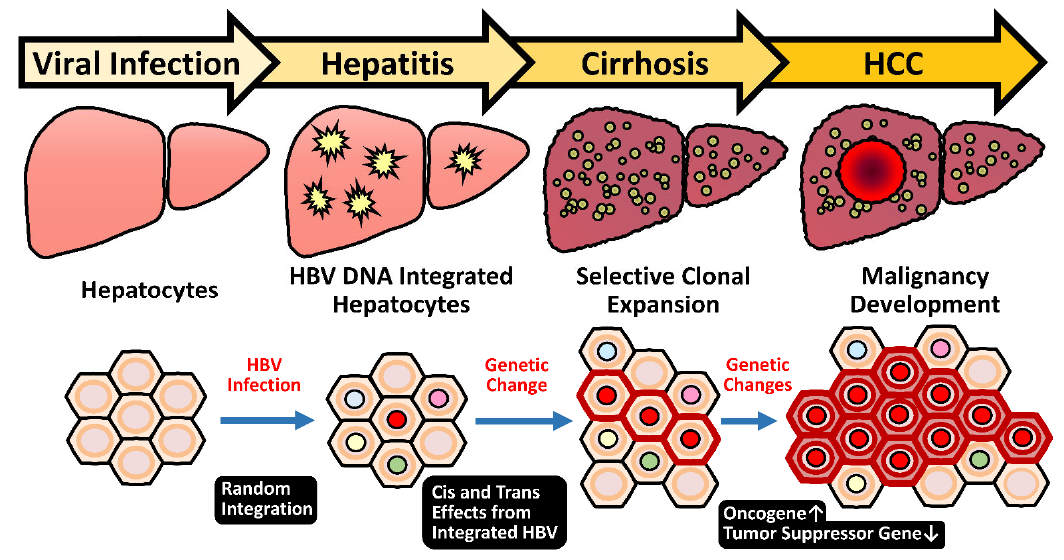
Figure 2. Insertional mutagenesis by integration of HBV genome predisposes potential genetic changes for selective clonal expansion in HCC development. After HBV infection, random integration of viral genome may occur (about 0.1%) in infected hepatocytes. The genetic cis and trans-regulatory effects derived from integrated HBV sequences may render the hepatocytes obtain a growth advantage. From CHB stage to cirrhotic phase, the repeated cycles of cell damage and hepatocyte regeneration may predispose the accumulation of other genetic changes. Therefore, this chronic inflammatory microenvironment sets up a scenario that promotes the hepatocytes with advantageous HBV insertional mutagenesis for clonal expansion and eventually selects for HCC formation.